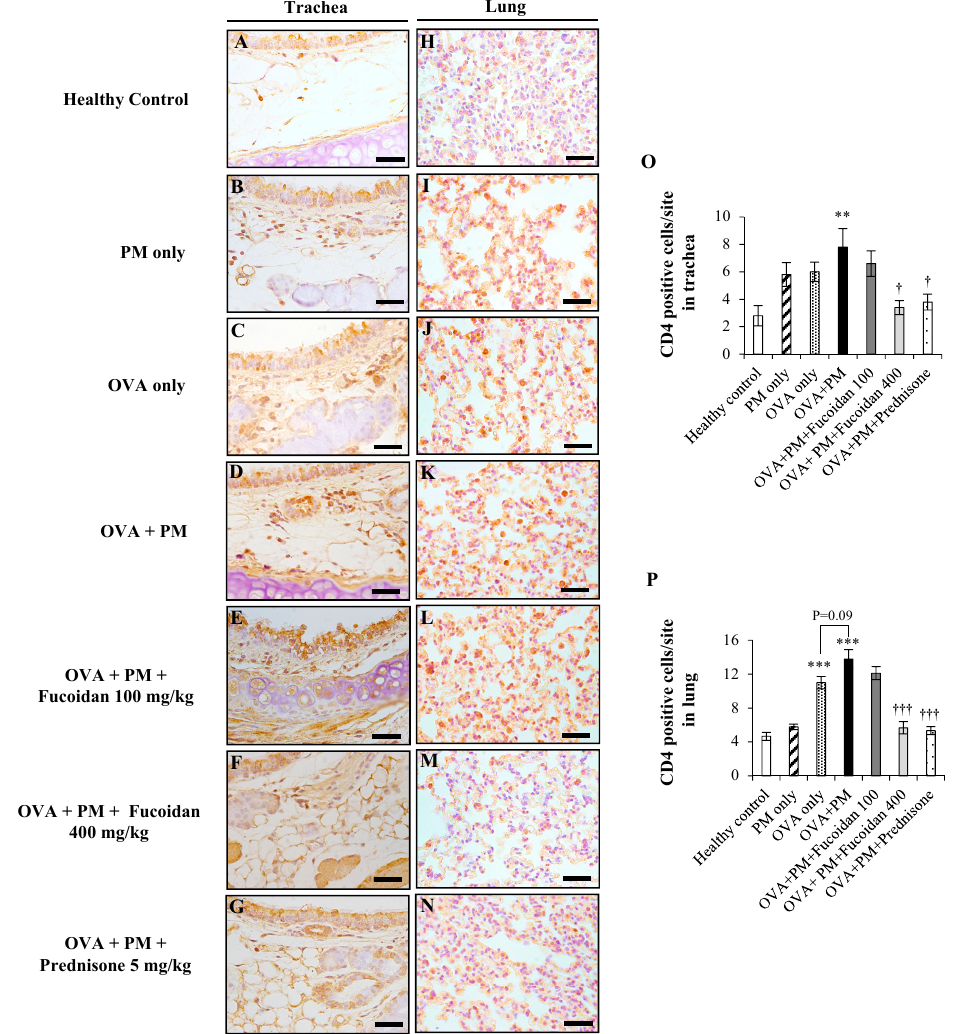
Figure 7. Immunohistochemical analysis of CD4 + T cells in the trachea ( A – G ) and lungs ( H – N ). ( A , H ) Healthy control, ( B , I ) PM only, ( C , J ) OVA only, ( D , K ) OVA + PM, ( E , L ) OVA + PM + Fucoidans (100 mg / Kg), ( F , M ) OVA + PM + Fucoidans (400 mg / Kg), ( G , N ) OVA + PM + Prednisone (5 mg / Kg). ( O ) Number of CD4 + T cells per site in the trachea, ( P ) number of CD4 + T cells per site in the lungs. Values are expressed as means ± SEM ( n = 3). ** ( p < 0.005), *** ( p < 0.0005) represent significant increases compared with the healthy control, and † ( p < 0.05), ††† ( p < 0.0005) denote significant decreases compared with the OVA + PM group. The scale bar of ( A – N ) is 25 µ